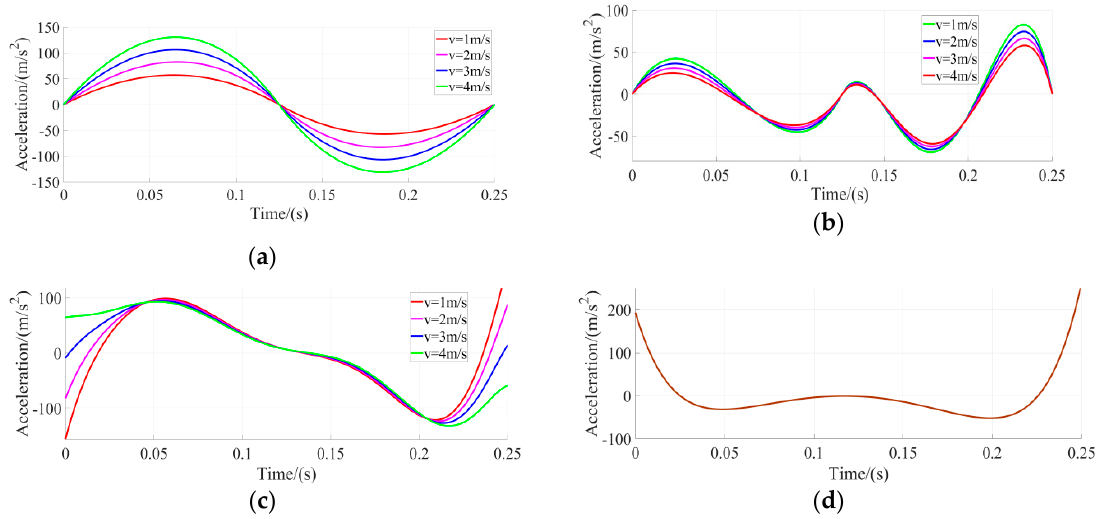
Figure 13. The endpoint acceleration of the leg calculated by MATLAB during the swing phase: ( a ) The acceleration in the X direction for the spline curve trajectory; ( b ) the acceleration in the Y direction for the spline curve trajectory; ( c ) the acceleration in the X direction for the Bézier curve trajectory; and ( d ) the acceleration in the Y direction for the Bézier curve trajectory.